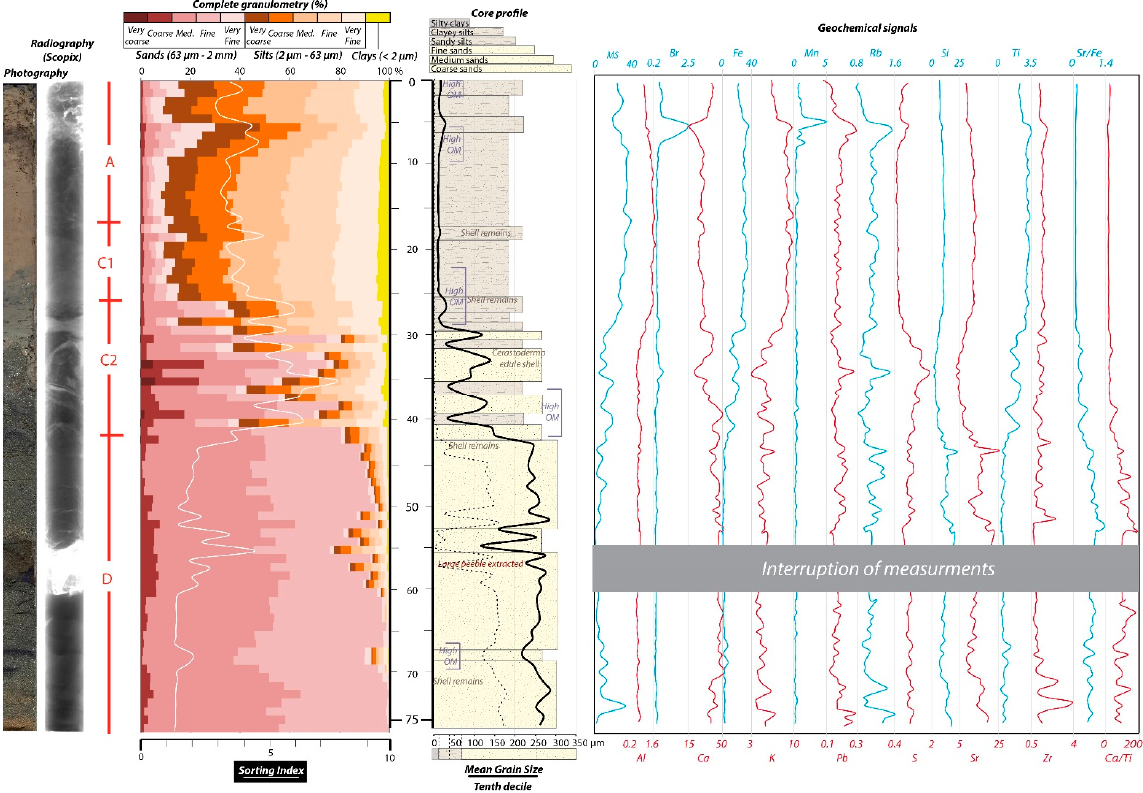
Figure 6. BH-E core log with photography, radiography, grain size results, and geochemical sig-